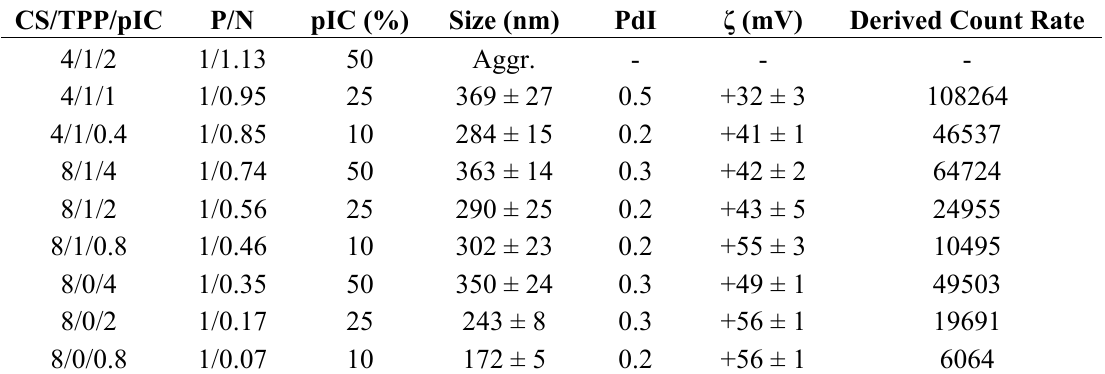
Table 2. Physicochemical characterization of Chitosan-Poly (I:C) nanoparticles at different mass ratios.